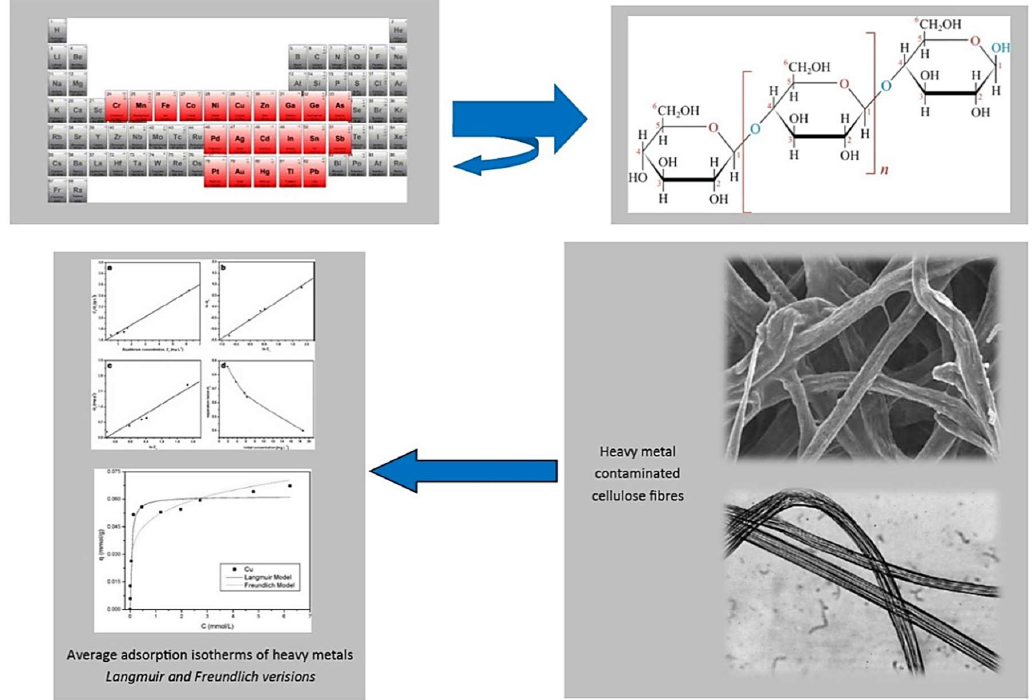
Figure A1. Sample of heavy metal treatment process from each wastewater sample by a typical cellulose adsorption method (Source: edited by authors).